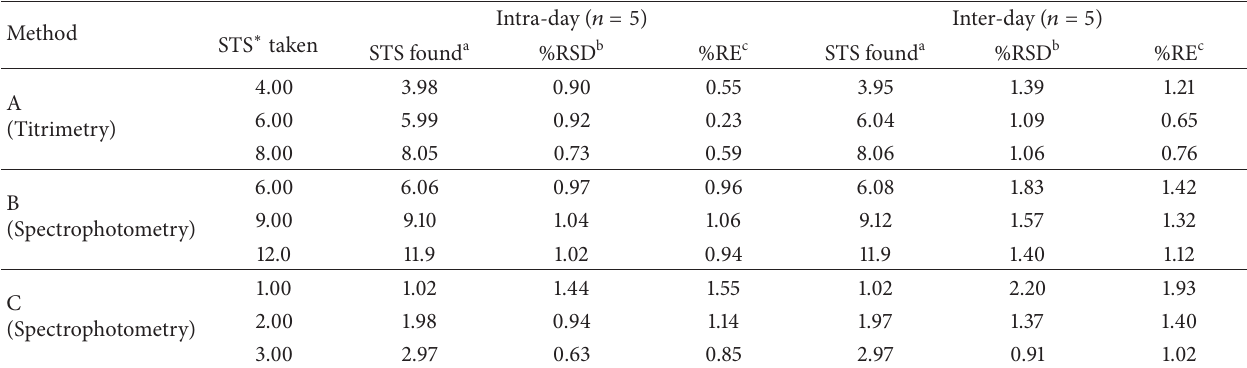
Table 3: Evaluation of intra-day and inter-day precision and